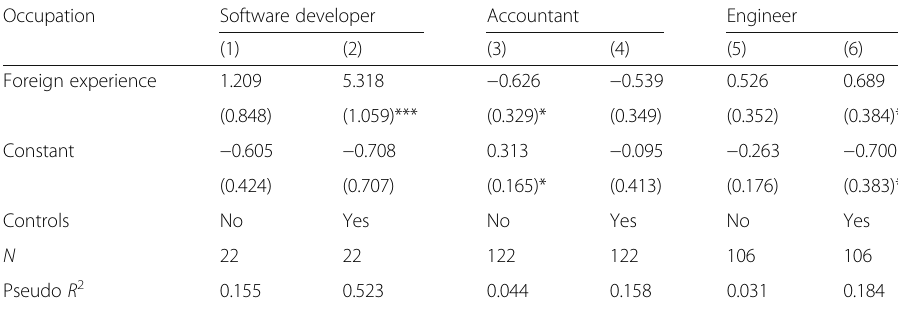
Table 17 Dependent variable: If a resume receives a callback conditional on employers that call back one applicant out of two (Probit regression)